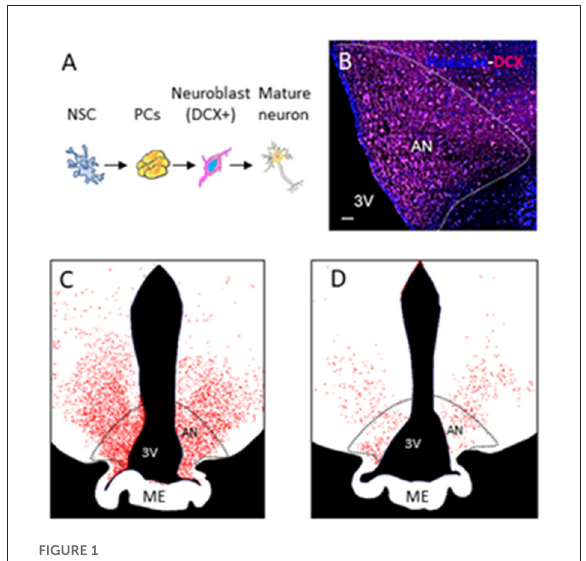
FIGURE1 Adult neurogenesis in the hypothalamus of sheep. (A) Different stages of adult neurogenesis from neural stem cells (NSCs) to DX-positive mature neurons. (B) Photomicrograph of DCX-positive staining in the arcuate nucleus of the sheep hypothalamus. (C,D) Drawings showing variations in DCX + staining during